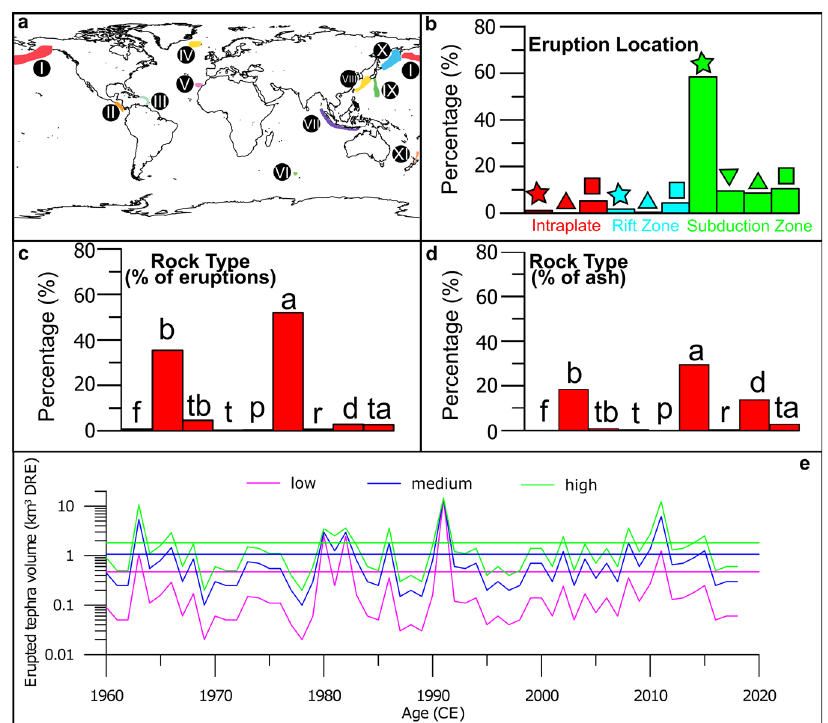
Fig. 1 Global map indicating volcanic provinces used in this study, and compilation of data from the Global Volcanism Program (GVP). a Source regions used to construct unaltered protolith compositions, indicated by numbers and coloured shading: (I) Aleutian Island arc, (II) Central American volcanic arc, (III) Lesser Antilles island arc, (IV) Iceland, (V) Azores, (VI) Kerguelen, (VII) Sunda arc, (VIII) Kyushu-Ryukyu arc, (IX) Izu-Bonin arc, (X) Kamchatka- Kurile arc, XI) Taupo volcanic zone. Map was created using the vector shorelines of ref. 66 . b Percentage of eruption events occurring at each type of volcanic location, denoted by colour and symbols for fully continental (star), intermediate locations on plate boundaries (upward-pointing triangle), oceanic (square) and unknown (downward-pointing triangle). c Proportion of each rock type as a percentage of all eruptive events since 1960. Rock types are foidite (f), basalt (b), trachybasalt (tb), trachyte (t), phonolite (p), andesite (a), rhyolite (r), dacite (d) and trachyandesite (ta). d Proportion of each rock type as a percentage of all ash deposited via eruptions since 1960, with rock types labelled as in panel c . e Erupted ash volume (in km 3 DRE) of each year since 1960, using GVP data representing the three ash volume scenarios (see Methods); ‘ low ’ (pink line), ‘ medium ’ (blue line) and ‘ high ’ (green line). The horizontal lines indicate the average values for each of the scenarios; 0.47 km 3 yr − 1 for ‘ low ’ , 1.07 km 3 yr − 1 for ‘ medium and 1.81 km 3 yr − 1 for ‘ high ’